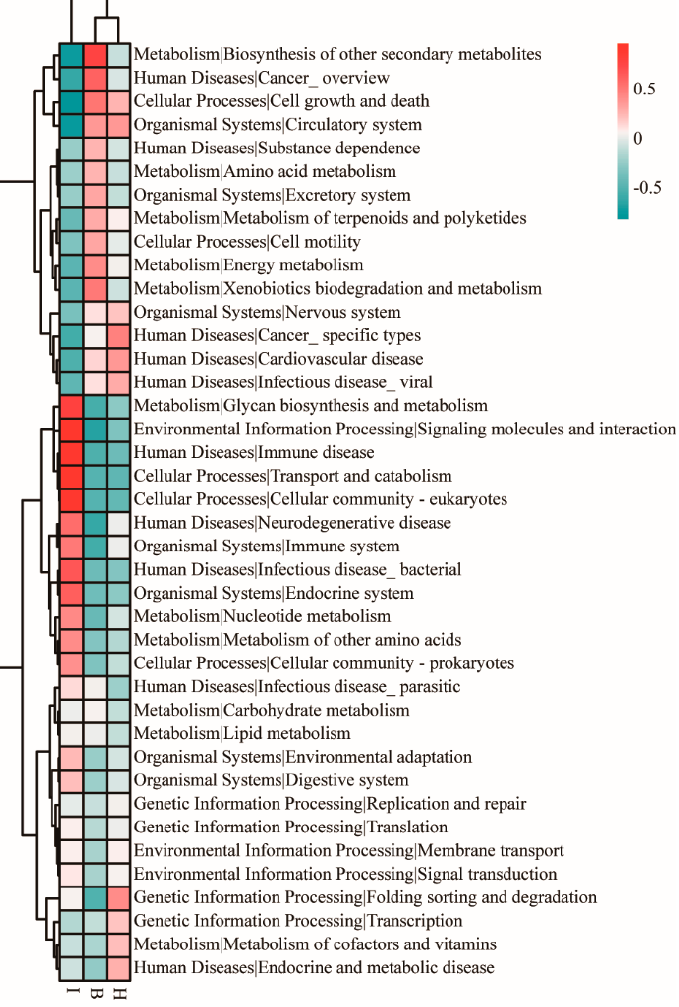
Figure 6. Heatmap profiles showing the functional categories (Kyoto Encyclopedia of Genes and Genomes (KEGG) level 2) of the bacterial communities, as predicted by Tax4Fun analysis. The functional clustering analysis is based on the unweighted pair-group method with arithmetic means (UPGMA). Rows represent the KEGG Orthology (KO) functions, columns represent the 36 samples, and the color intensity in the heatmap represents the relative abundance of the functional categories.